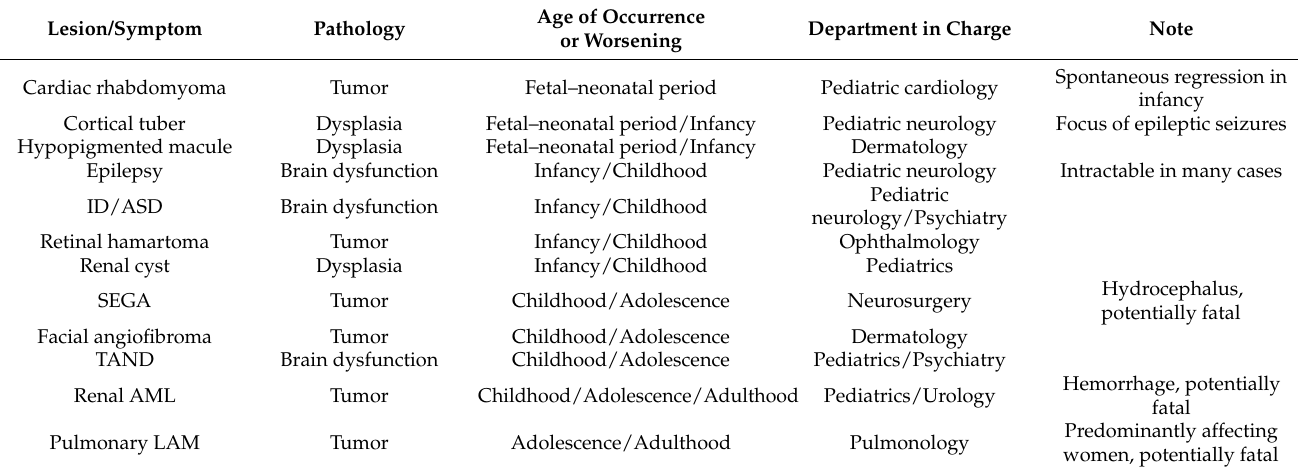
Table 2. Age-dependent changes of lesions and symptoms in